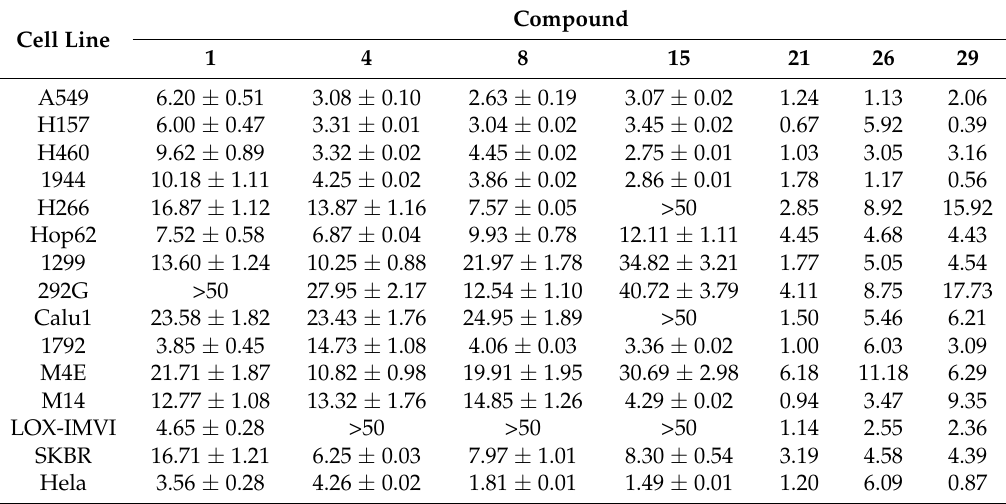
Figure 5. Structures of O -alkylated quercetin derivatives ( 21 – 50 ). Abbreviations: Et: ethyl, Pr: propyl, Bu: butyl, Pe: pentyl, H x : hexyl, i -Pr: isopropyl, i -Pe: isopentyl, Bn: benzyl. Speaking of these studies, cytotoxicity data of the most representative O -alkylated quercetin derivatives are listed in Table 2. Table 2. Cytotoxicity data of the most representative O -alkylated quercetins compared to quercetin by high-throughput screening (HTS) method 1 .